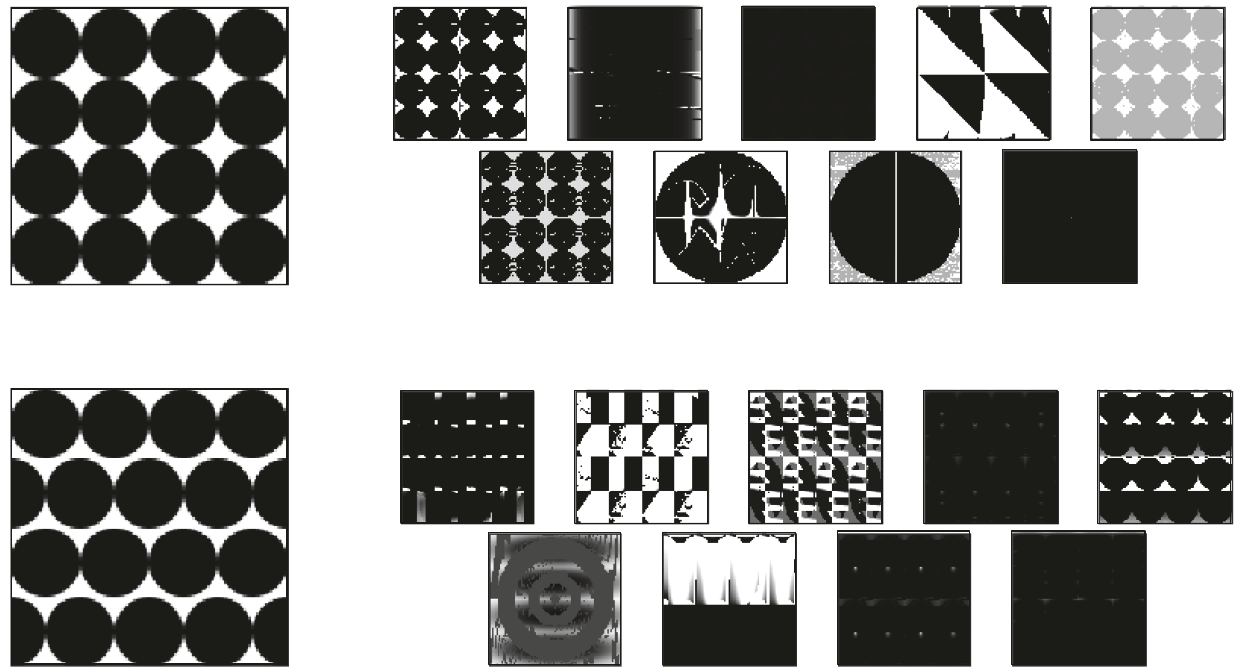
Figure 9: Circle, grid, and offset language summary